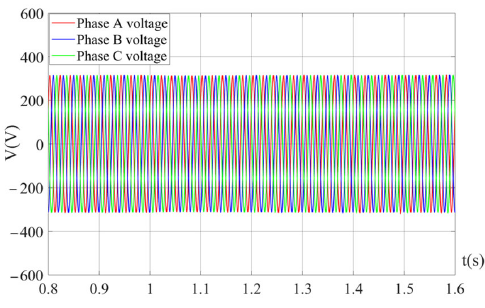
Figure 11. Three ‐ phase voltages of AC bus (Group A). Figure 11. Three-phase voltages of AC bus (Group